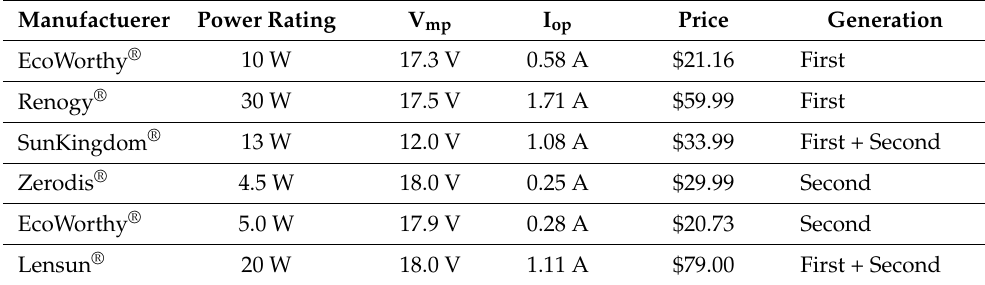
Table 1. Analysis of solar panels in the current